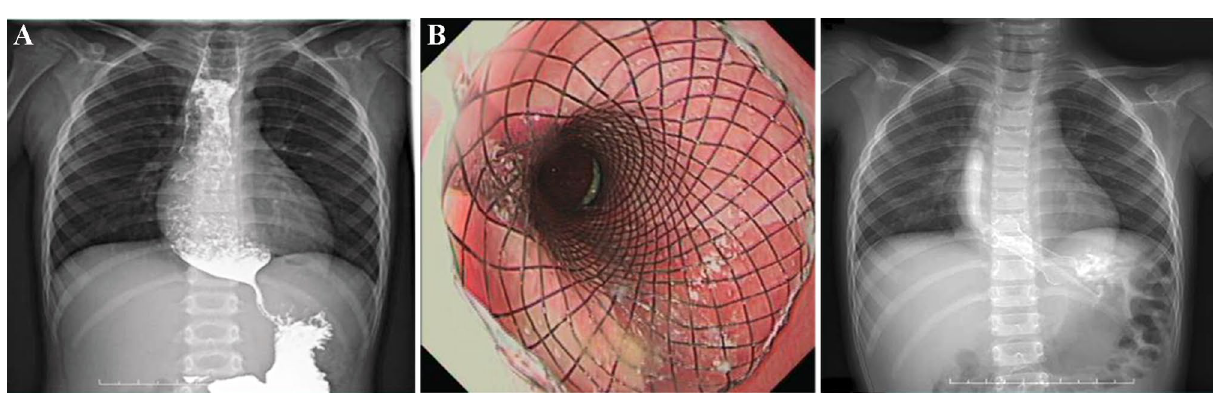
Figure 4. Stent placement in a patient with achalasia of cardia (case 12). ( A ) The upper gastrointestinal tract radiography showed a beak-like change, suggesting it was difficult for the barium to pass through before surgery; ( B ) A stent was placed and expanded as the patient body temperature rose; ( C ) Upper gastrointestinal tract radiography showed normal passing through of the contrast agent after stent